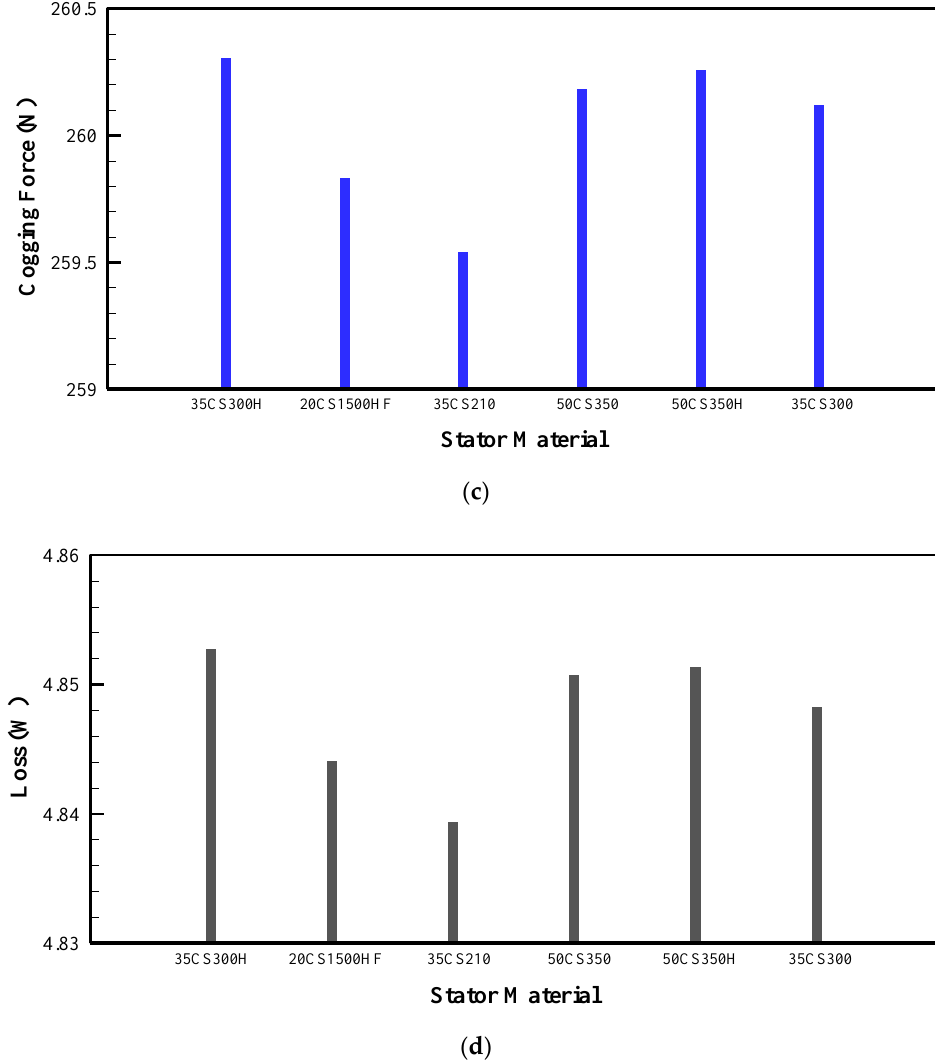
Figure 9. Influence of Stator material on ( a ) induced power, ( b ) voltage, ( c ) cogging force on the translator, and ( d ) losses.